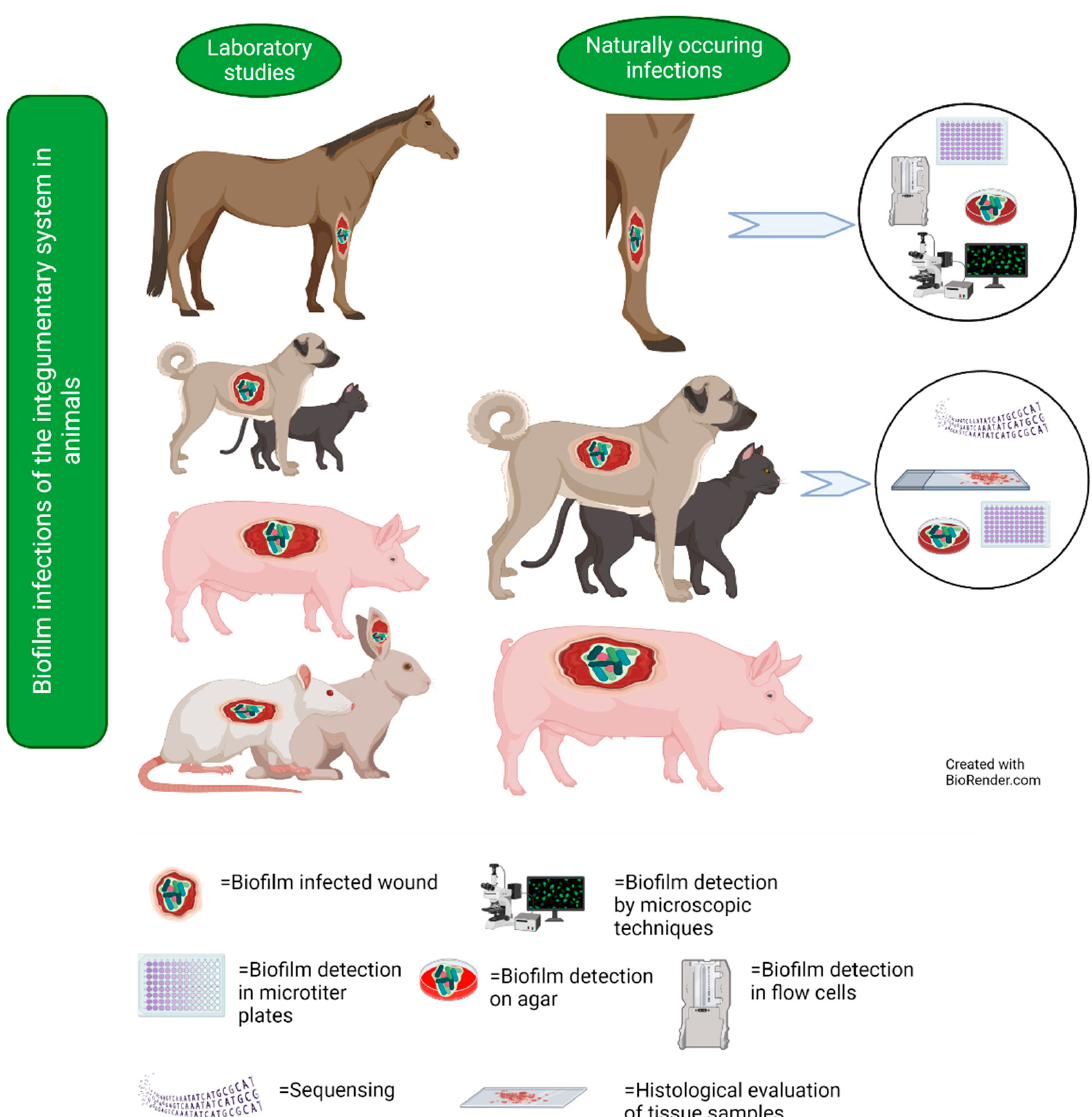
Figure 4. Studies on naturally occurring and experimental wound infections, including information on techniques that have been used in studies on natural infections in horses and dogs. Below are explanations of the symbols used in the figure.